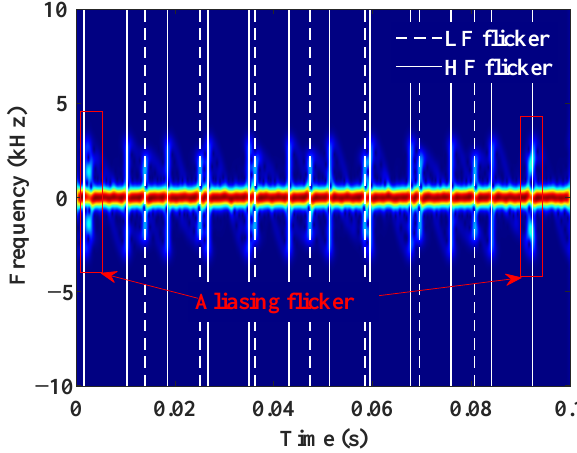
Figure 13. Time–frequency spectrum full flashing time domain location tag diagram.